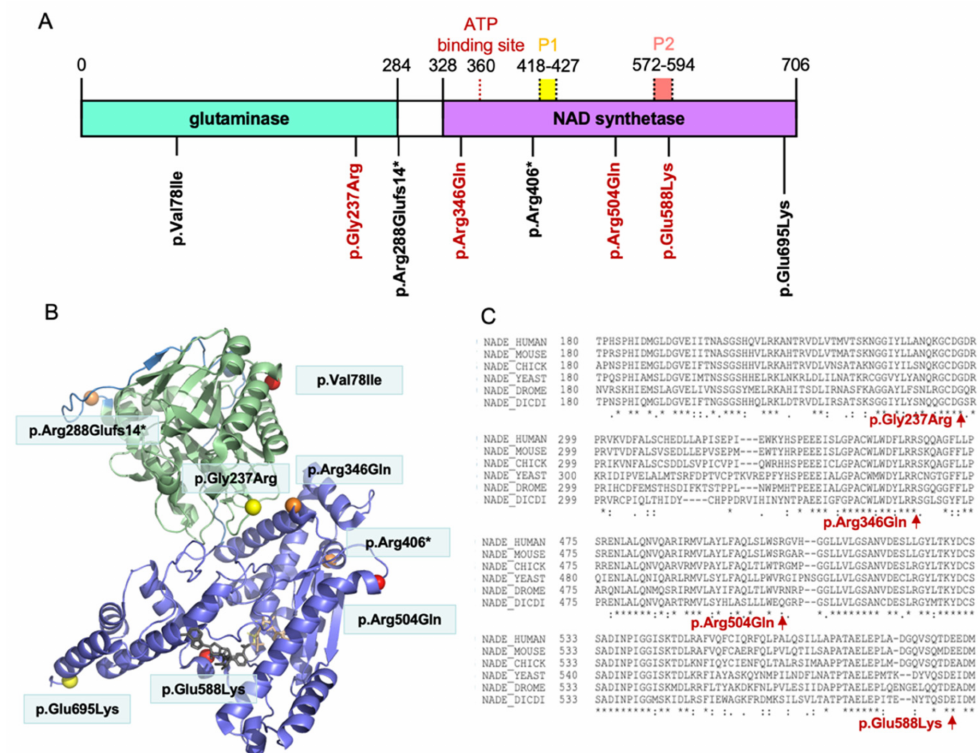
Figure 1. ( A ) Protein domain diagram of human NADSYN1 and the position of identified variants. The glutaminase domain is labeled in green, NAD synthetase domain in purple, P1 loop in yellow, P2 loop in pink, and ATP binding site in red, respectively. The RefSeq transcript sequence of NADSYN1 gene is NM_018161.5; PDB accession code: 6OFB. ( B ) Space distribution of variants in 3D